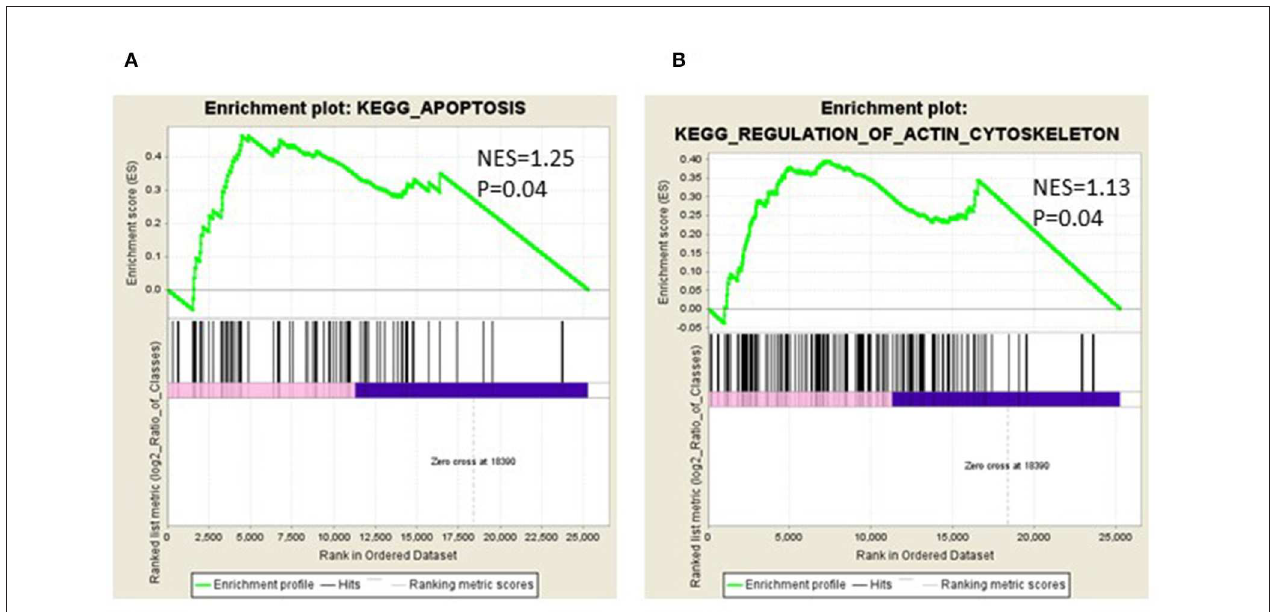
Frontiers in Oncology |